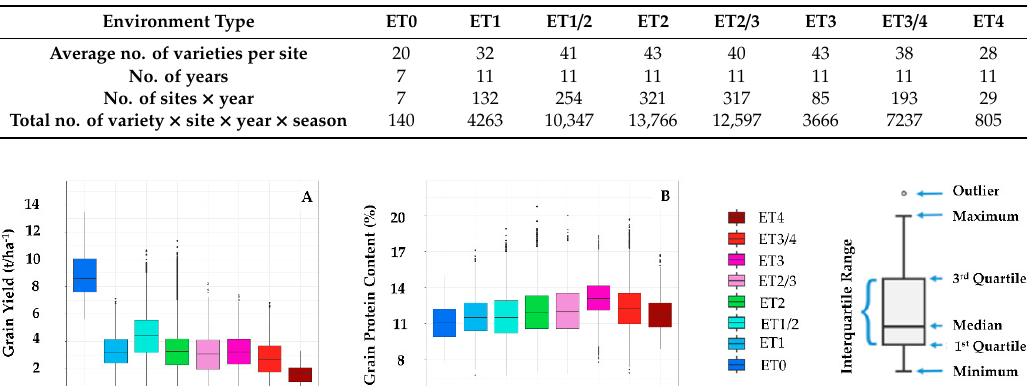
Table 1. General information about National Variety Trials (NVT) dataset. The average number of varieties per site, number of years, total number of sites during consecutive years, and total number of data in individual environment types (ETs).